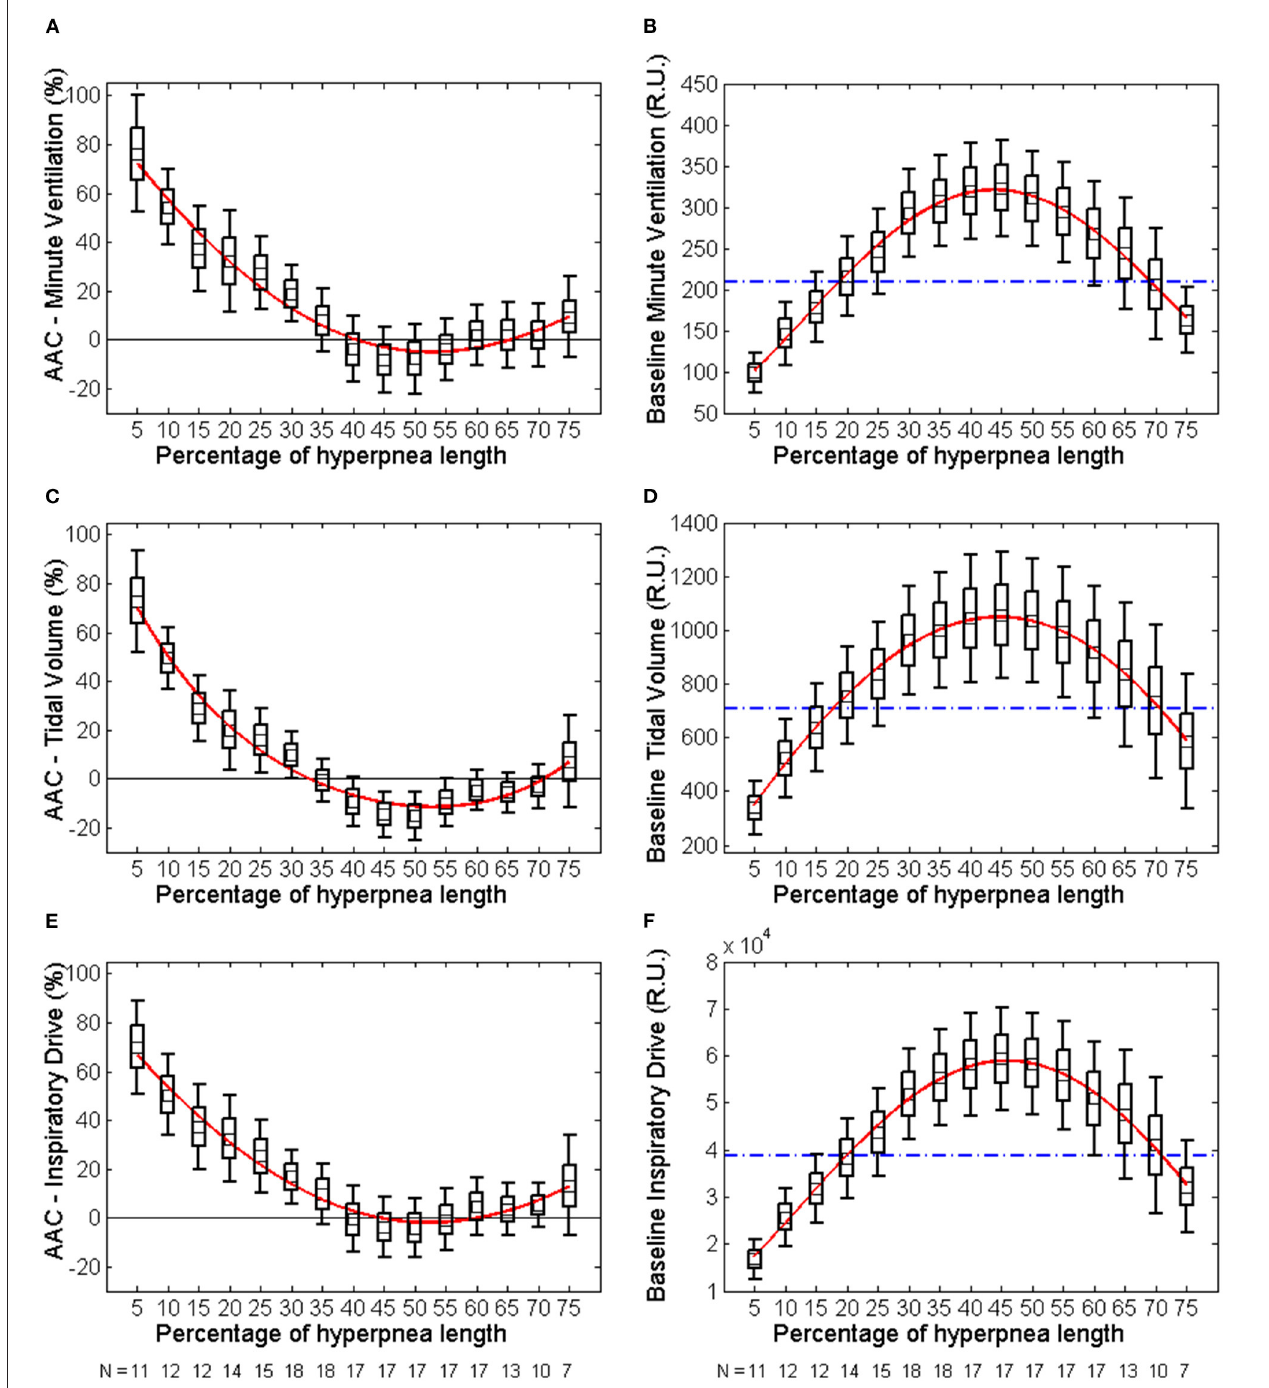
FIGURE 6 | Left: descriptive statistics of the time course of the arousal-associated change (AAC) in minute ventilation (A) , tidal volume (C) and inspiratory drive (E) as a function of the percentage of hyperpnea length (middle point of each box: mean; box: mean ± SE; whiskers: mean ± 95% confidence interval). The AAC is expressed as a percentage of the average value of these parameters in the absence of arousals during hyperpneas (see equation 1). Whiskers not crossing the zero line indicate that the corresponding mean is significantly different from zero. Red solid lines are 4 th -order polynomial fittings of mean values. Right: descriptive statistics of the time course of baseline values of minute ventilation (B) , tidal volume (D) and inspiratory drive (F) during hyperpneas. The blue dashed-dotted line is the mean normalization factor used for the estimation of the AAC in each patient (i.e., the denominator of equation 1). The numbers at the bottom of left and right panels indicate in how many patients the AAC could be estimated (at least 5 case-control pairs were required for each breath). RU, relative units.